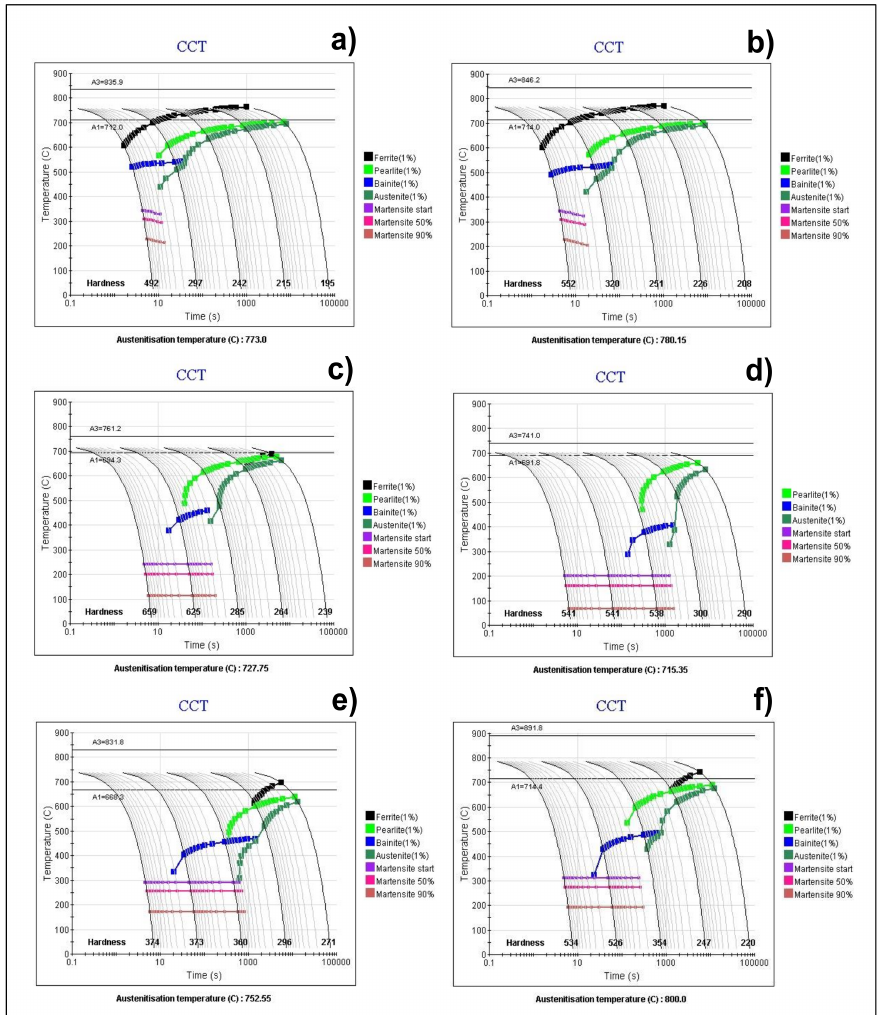
Figure 2. Intercritical CCT diagrams: ( a ) AISI-1015; ( b ) modification of contents of Cu, Al, Mo and Si; ( c ) variation in the concentrations of C and Mn; ( d ) changes in the contents of Ni, Cu, Mo, Si; ( e ) modification in the amount of Al, Cu, Mn, Mo, Ni, Nb, C; ( f ) experimental